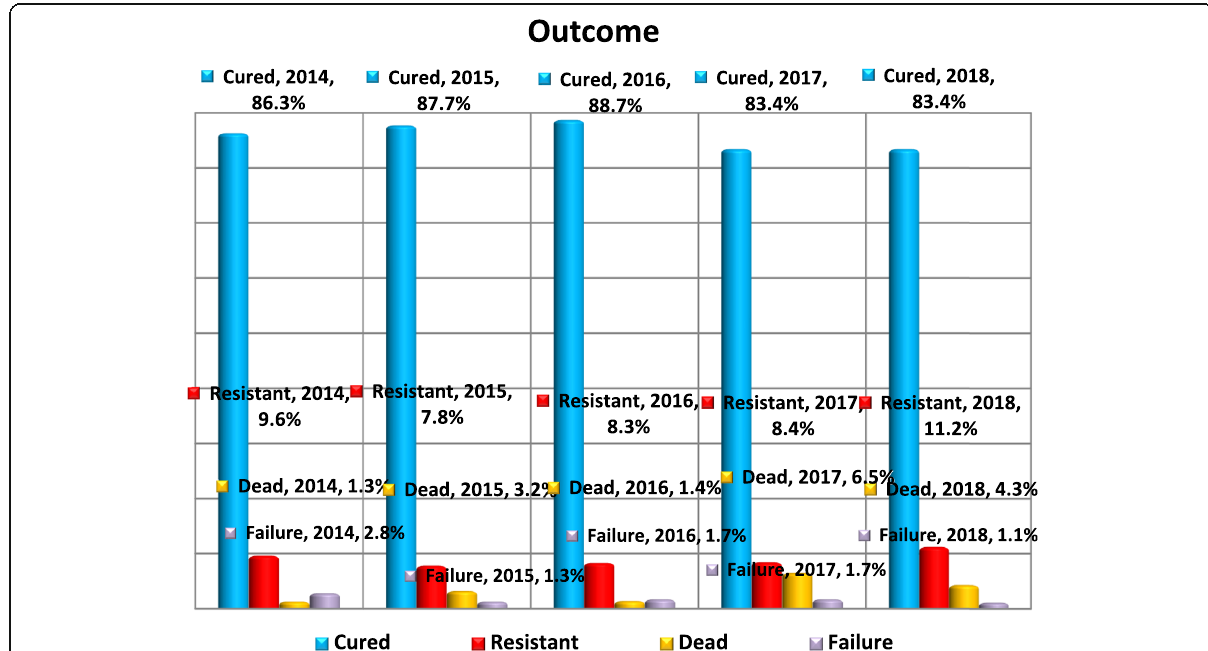
Fig. 1 Distribution of cases according to the treatment outcome during the period of the